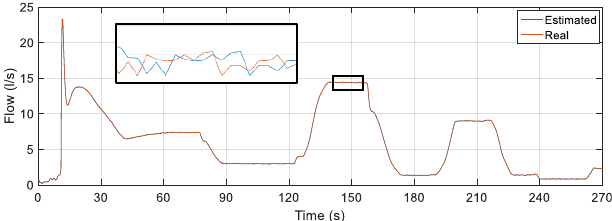
Figure 16. Estimated and real Flow: Testing A. Table 6. Ratio between statistical measures: testing A.